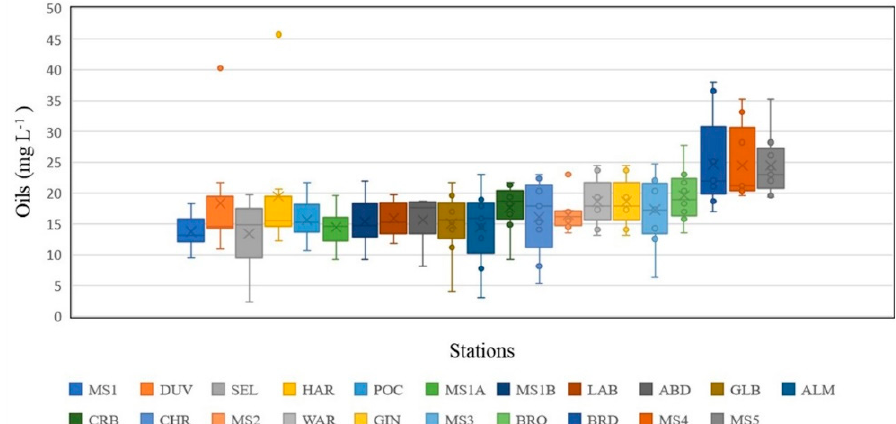
Figure 10. Box and whisker plot for the general Oil concentrations in the main stem and triblet locations, South River, MD. Triblet BRD and MS4 are like each other, but different from all other stations. Whereas MS5 is completely different from all other stations.